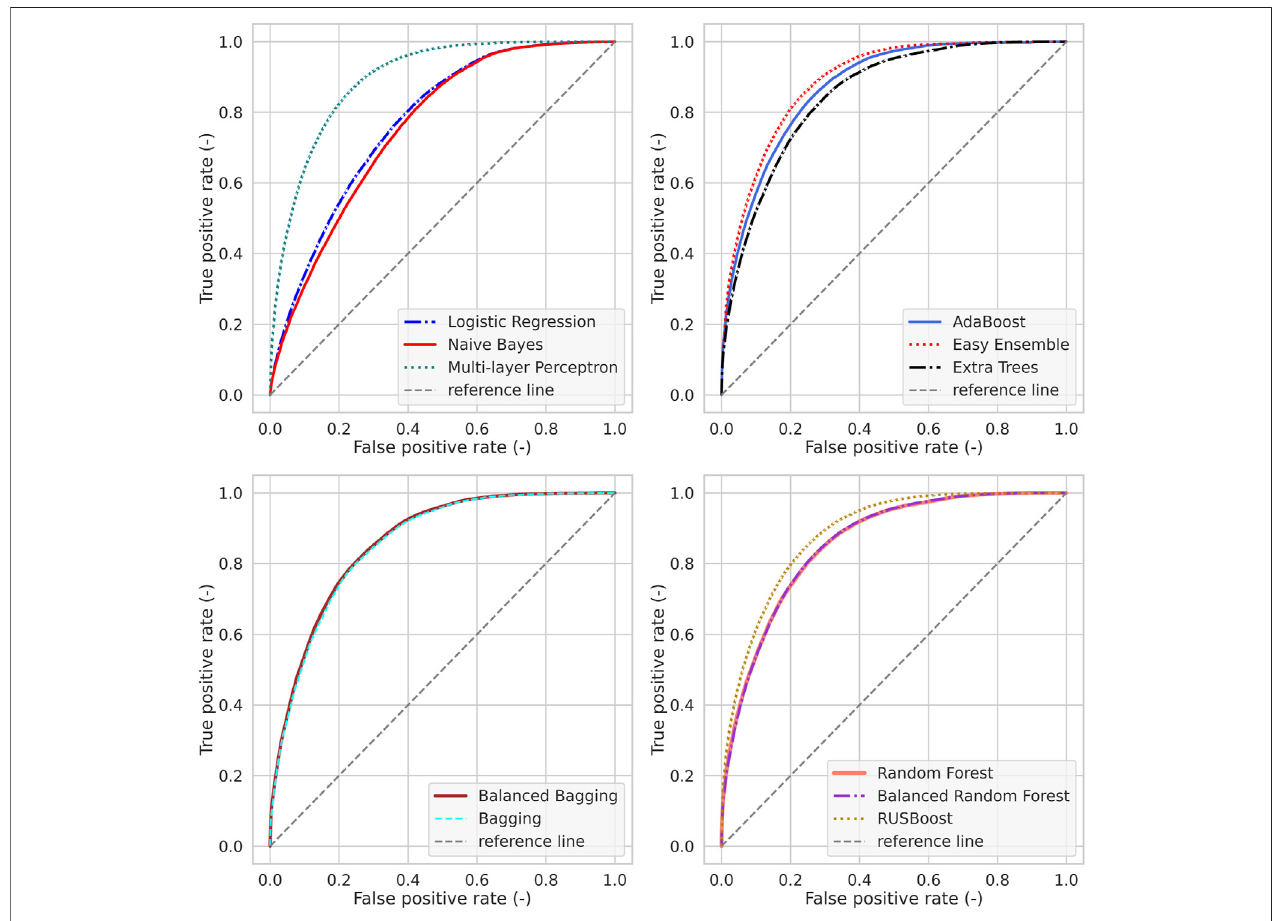
FIGURE 7 | Receiver Operator Curves for the test